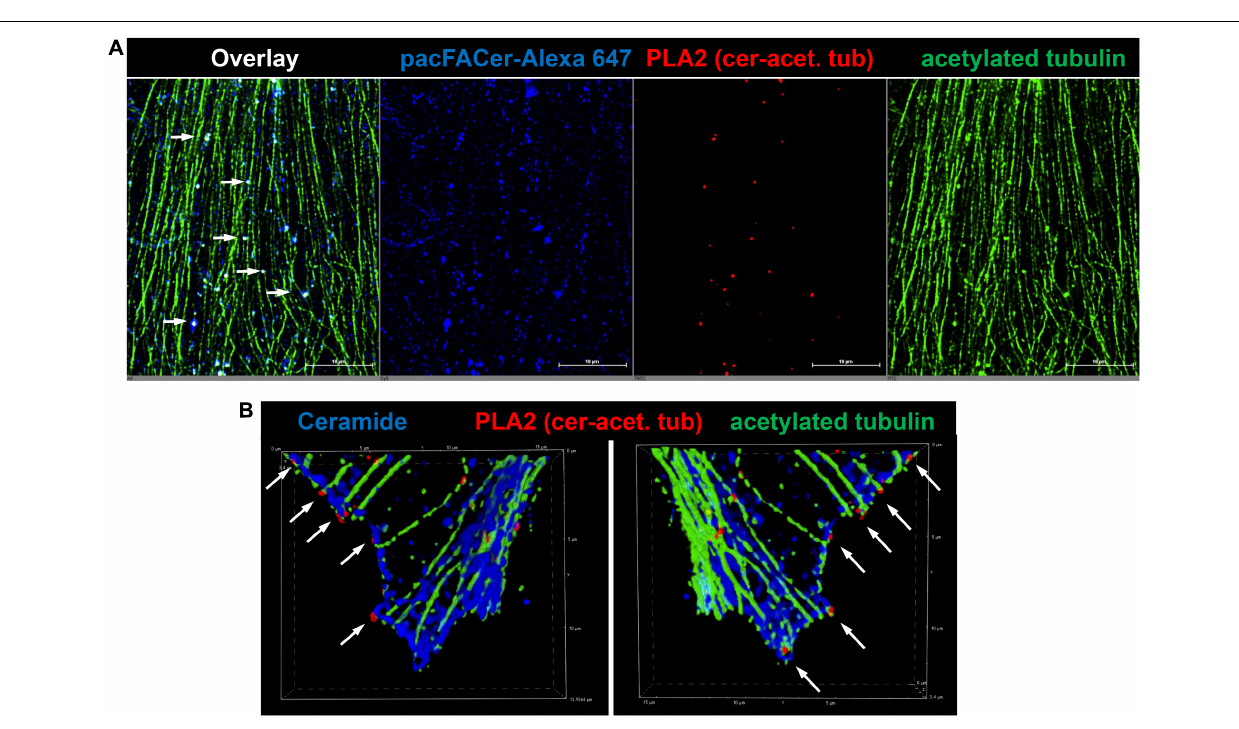
Frontiers in Cell and Developmental Biology |